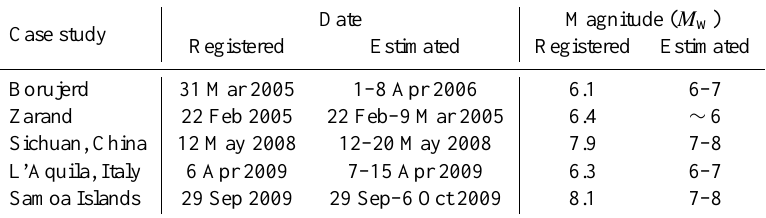
Table 9. Case studies accompanied by the registered and estimated earthquake